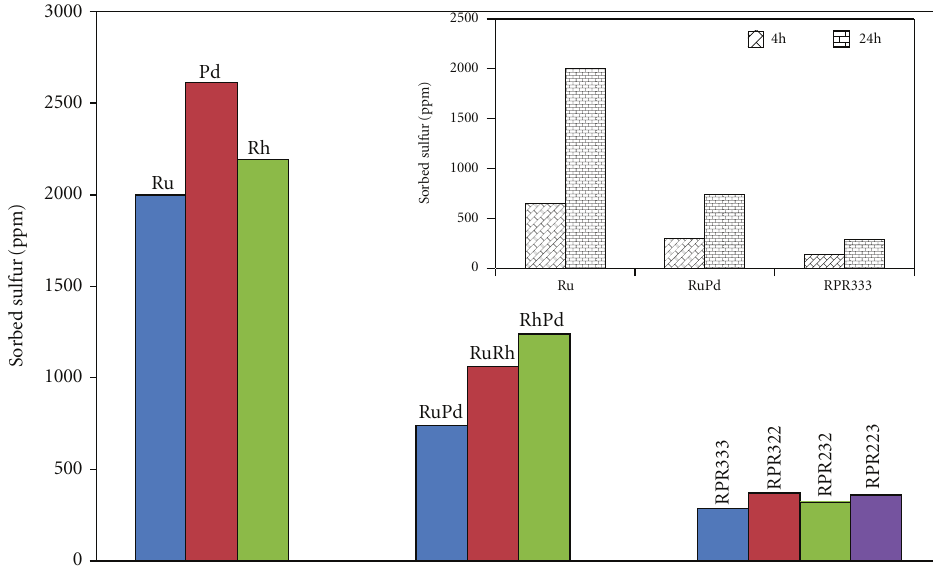
Figure 3: Comparison of sulfur-sorption characteristics of trimetallic catalysts during 24 hours soak at 800 ◦ C in 1000ppm H 2 S/bal. N 2 ambient, with those of mono- and bi-metal analogs. Inset: sulfur sorption profiles of three typical catalysts (one from each series) during 4 and 24 hours soak